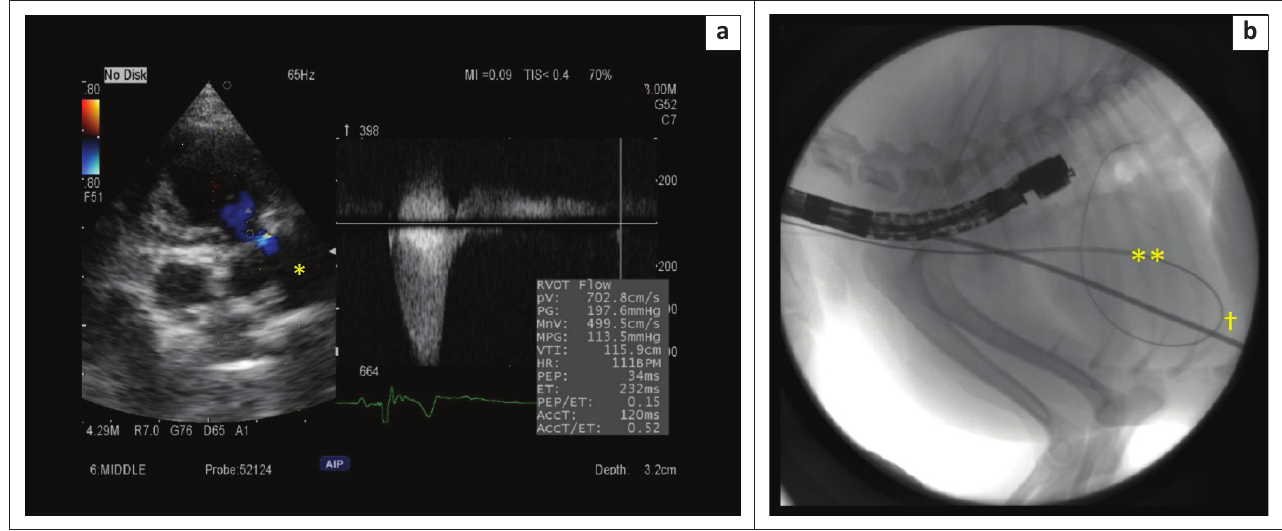
FIGURE 1: Case 1; (a) Right parasternal short-axis view at the level of the aorta and pulmonary artery: A transthoracic echocardiogram showed pulmonary stenosis (pulmonic velocity 7.0 metres per second, peak systolic gradient 197.6 mmHg) on day 1, pulmonary artery ( * ); (b) Surgical fluoroscopy image on day 6 (first surgery). The guidewire was advanced to the right ventricular apex and retroflexed to reach the site of stenosis in the main pulmonary artery. However, the balloon could not follow the guide wire ( ** ) because it was unable to turn at the sharp curve at the right apex ( †